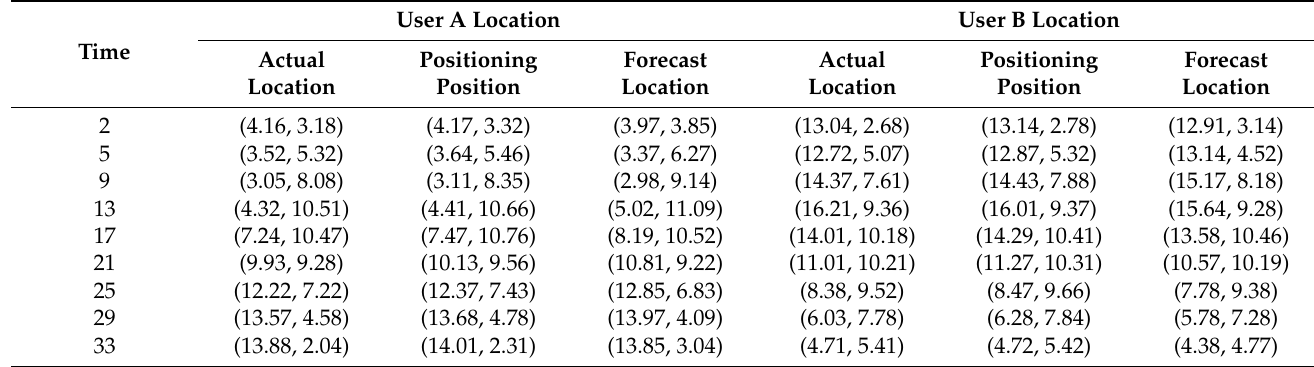
Table 7. Comparison table of user’s actual location and measurement